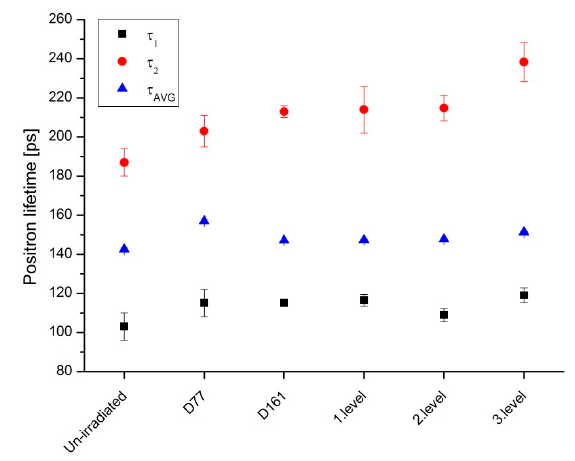
Figure 1. Positron lifetimes of all measured P370 WM specimens–unirradiated, neutron irradiated (D77 and D161) and 3 levels of H + ion irradiated.